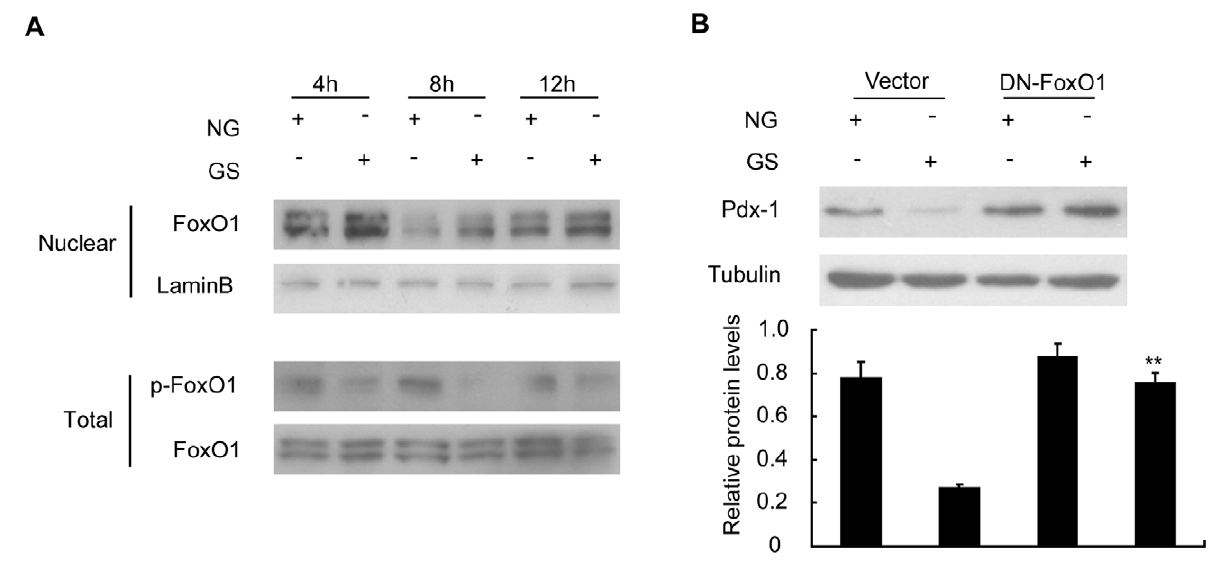
Figure 4. Glycated serum (GS) promoted Foxo1 nuclear accumulation to reduce Pdx-1 stability. (A) INS-1 cells were treated with nonglycated (NG) or 10% GS for the indicated periods of time. All the cells were collected for total protein and nuclear protein extraction. Western blot assay was used to detect the phosphorylated-Foxo1, total Foxo1, and nuclear Foxo1. (B) INS-1 cells overexpressing DN-Foxo1 construct were cultured for 24 h and then treated with nonglycated (NG) or 10% glycated serum (GS) for another 24 h. Pdx-1 protein level was determined by western blot assay. Representative immunoblots and a graph showing the protein levels of Pdx-1 relative to a -tubulin are presented. Data are represented of three separate experiments. **p , 0.01 vs. GS, vector-transfected group.